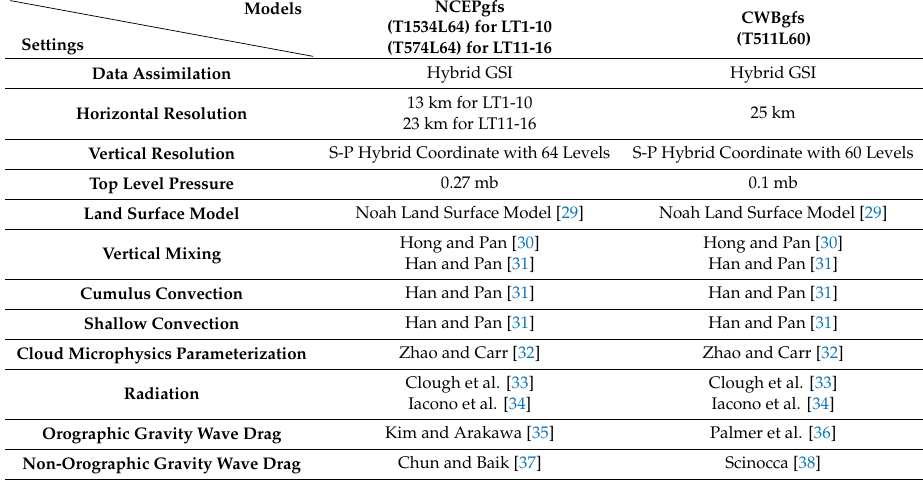
Table 1. Detailed information about NCEPgfs and CWBgfs. LT1-10 (LT11-16) denotes lead-time